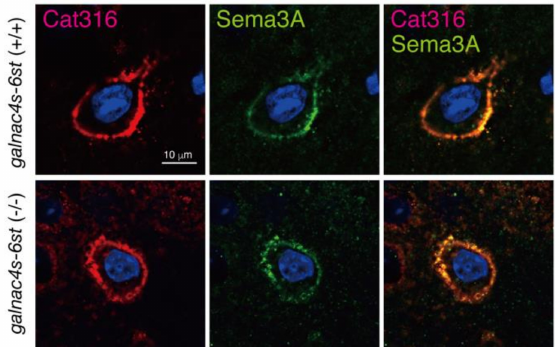
Figure 5. Sema3A is co-localized in Cat316-positive CSs even in the absence of E units Coronal sections from the brains of 10-week-old galnac4s-6st ( +/+ ) and galnac4s-6st ( − / − ) mice were stained with Cat316 mAb and anti-Sema3A antibody. Sema3A proteins also accumulated in E units-deficient